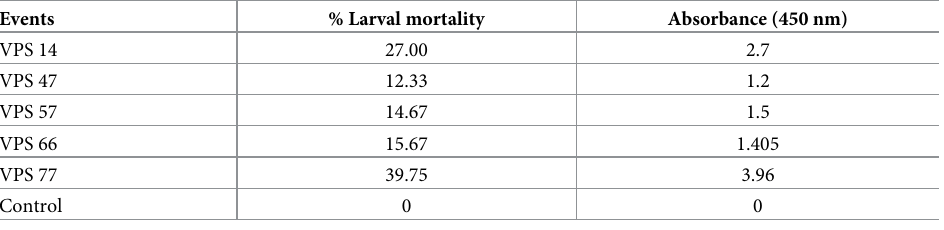
Table 2. cmVIP3Aa specific absorbance (at 450 nm) vis a vis larval mortality in transgenic